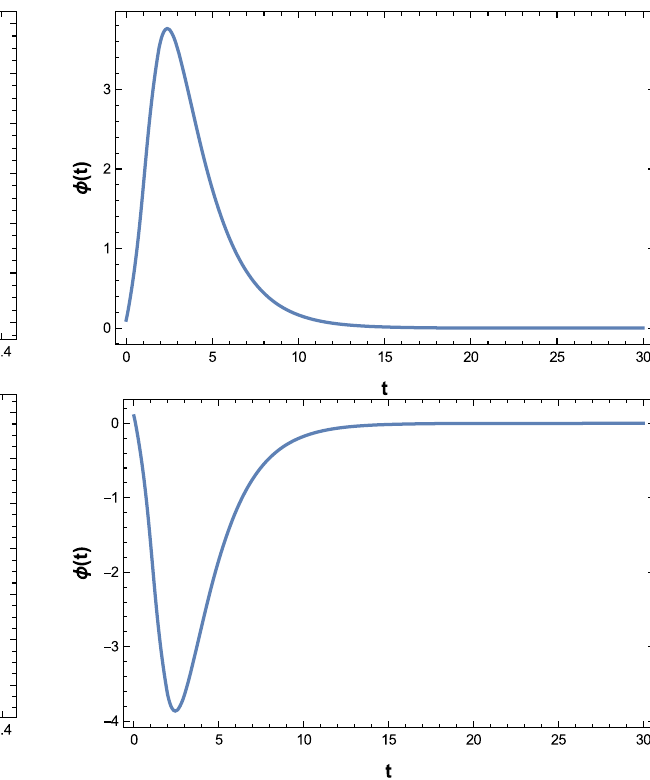
Fig. 3 Evolution of the scalar field during collapse. a 0 = 1 and m = 1 √ . The initial conditions chosen for the numerical solutions are the 2 for an initial time t i . The graph on top is for values of a ( t ) and da ( t ) dt > 0 and the graph on bottom are for initial initial condition da ( t ) dt t = ti < 0 condition da ( t ) dt t = ti